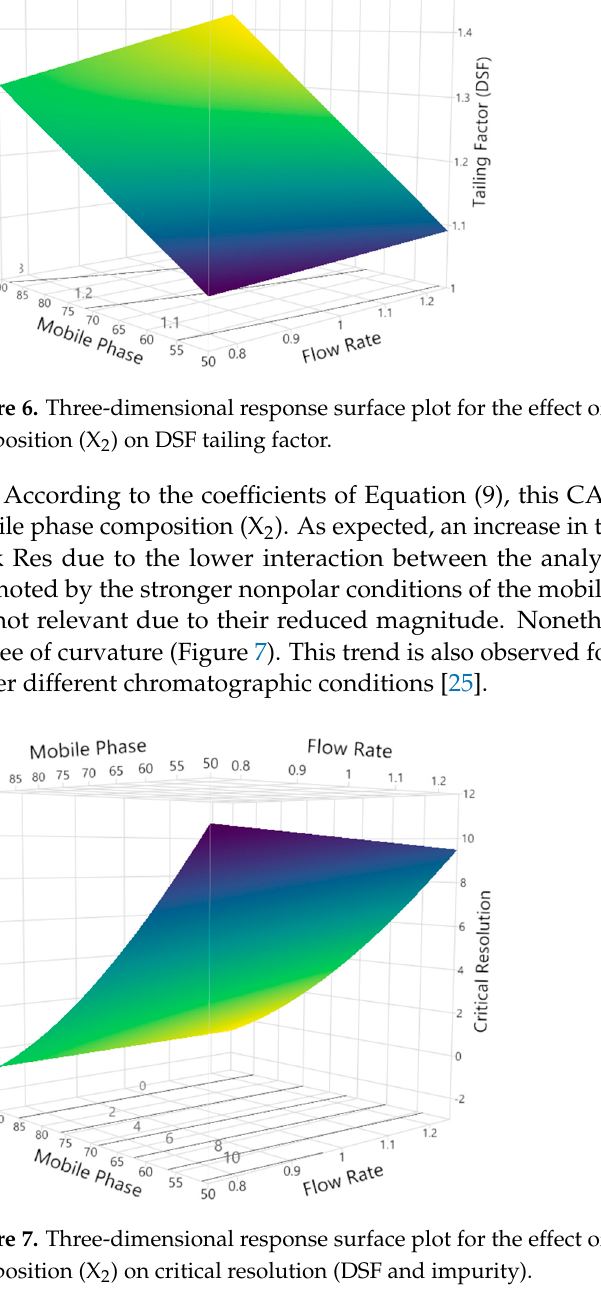
Figure 6. Three-dimensional response surface plot for the effect of flow rate (X 1 ) and mobile phase composition (X 2 ) on DSF tailing factor.